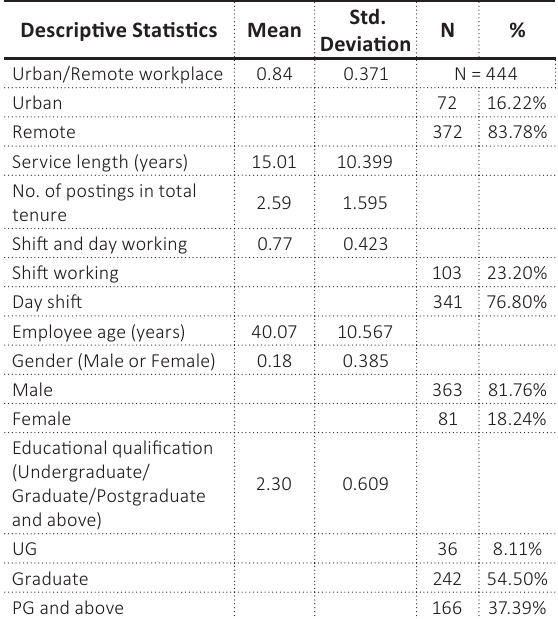
Table 1. Demographic profile of respondents